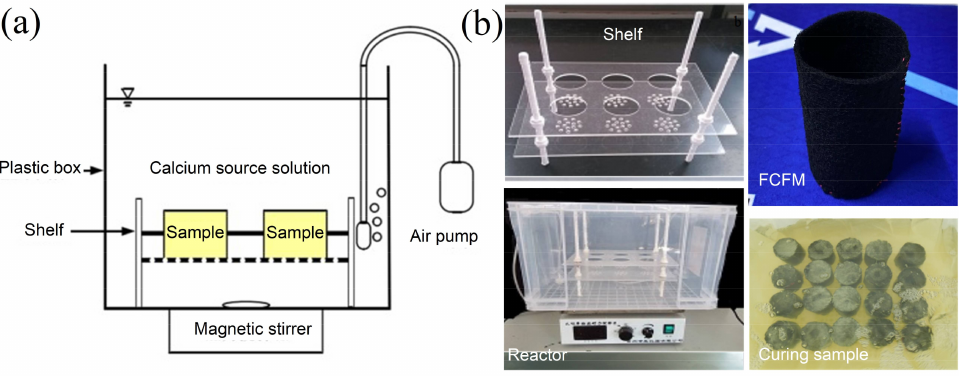
Figure 5. Schematic drawings of MICP reactor: ( a ) reactor; ( b ) MICP